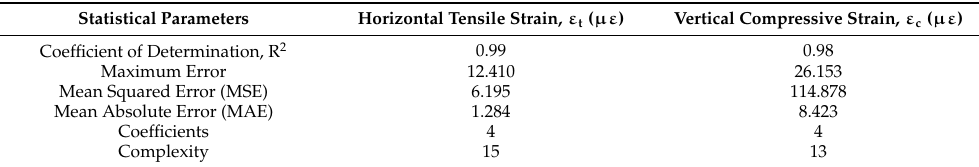
Table 4. Statistical parameters for ε t and ε c .